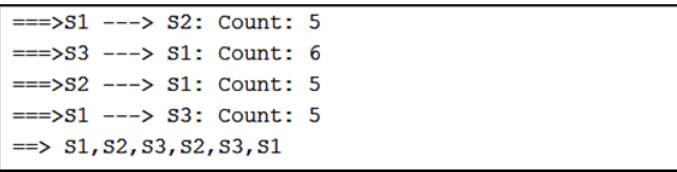
Figure 17. Algorithm 2 ’ s output for Path 3.